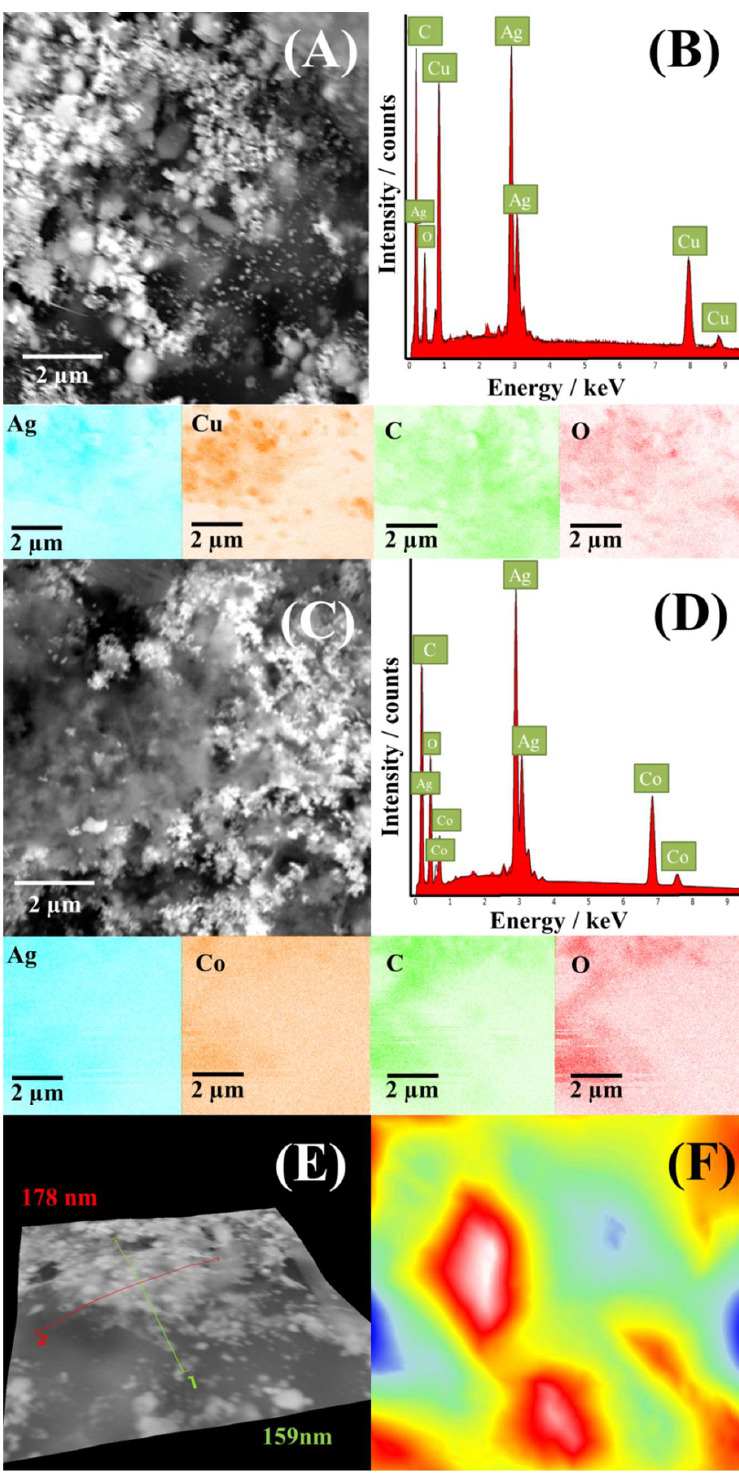
Figure 3. SEM images of CuAg/rGO ( A ) and CoAg/rGO ( C ) electrocatalysts with the corresponding EDS spectrum of CuAg/rGO ( B ) and CoAg/rGO ( D ) and mapping images of Ag, Cu, Co, C, and O with the corresponding 3D SEM surface reconstruction ( E , F ).